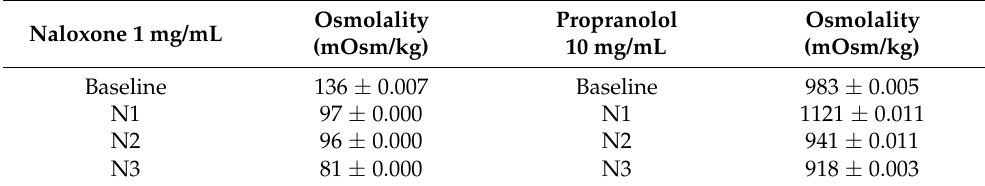
Table 6. Osmolality of the oral liquids containing naloxone and propranolol with 0% glycerol. Mean value ± coefficient of variation (n = 2). Compositions of formulations N1–N3 according to Tables 4 and